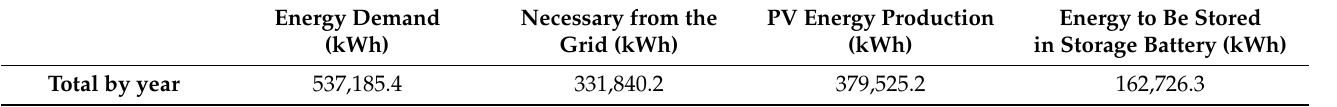
Table 4. Calculation for energy produced, required from the power grid and required to be stored, for one day and for month of July.